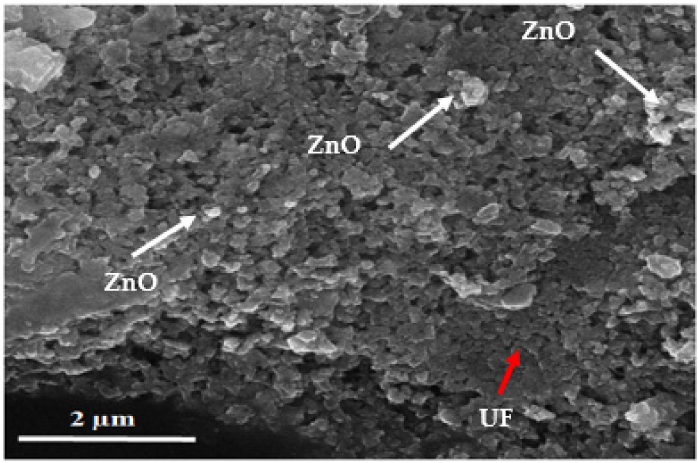
Figure 4. Scanning electron microscopy image of cured UF-ZnO nanofillers.